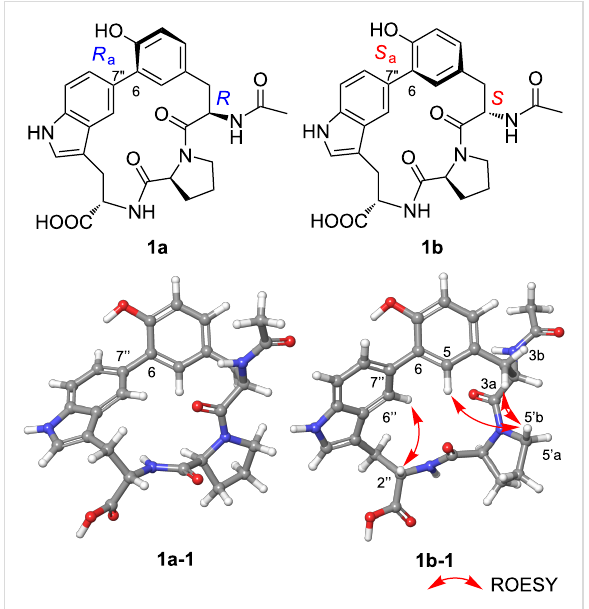
Figure 4: The opposite axial chirality around the biaryl C-6–C-7'' bond influenced by the C-2 configuration in compound 1 . 3D structures 1a-1 and 1b-1 are the most stable conformers of 1a and 1b , respectively.